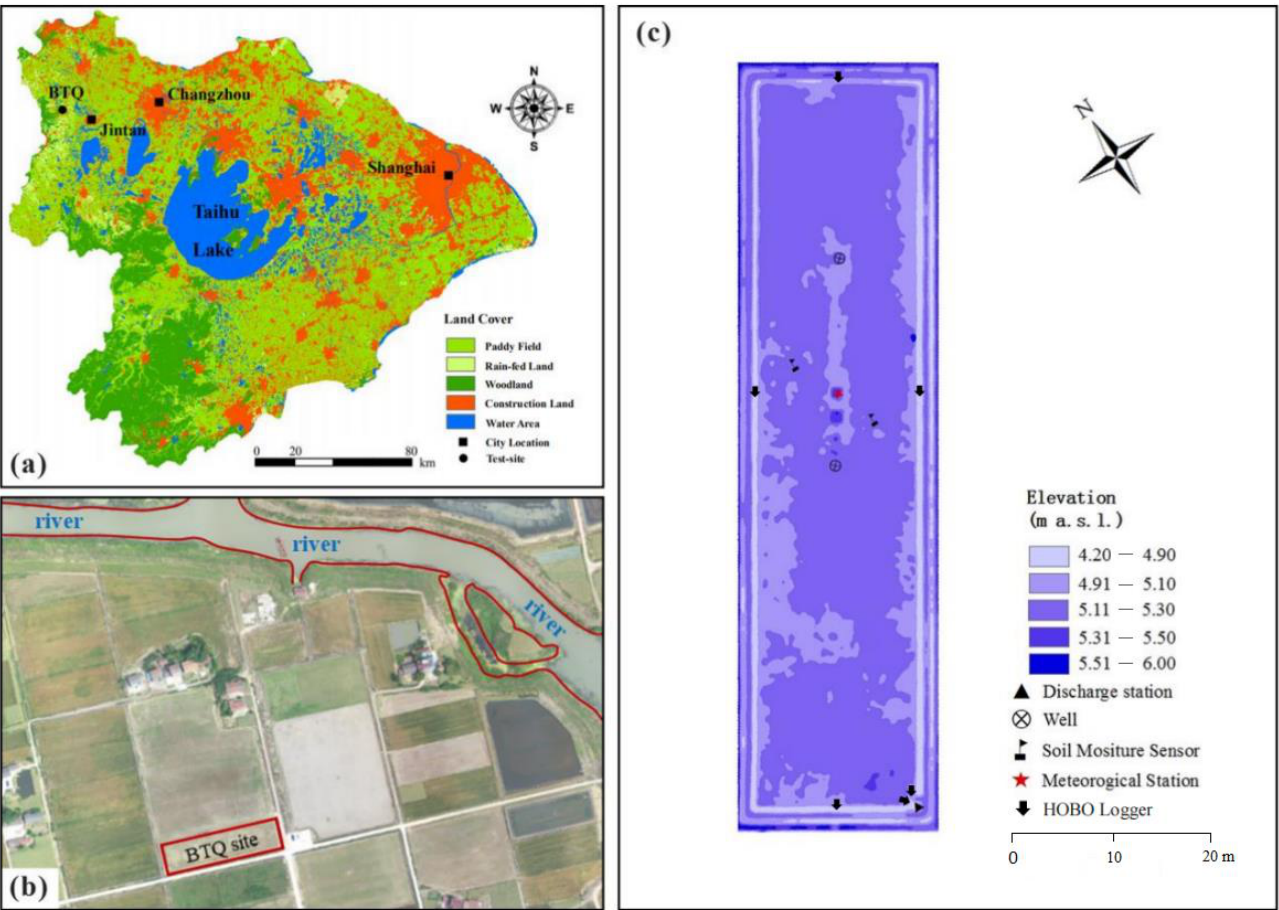
Figure 1. ( a ) Sites of the study in the Taihu Basin, ( b ) Baitaqiao (BTQ) hydrology test site location and its surroundings, and ( c ) surface elevation and instrumentation in the BTQ site. its surroundings, and ( c ) surface elevation and instrumentation in the BTQ